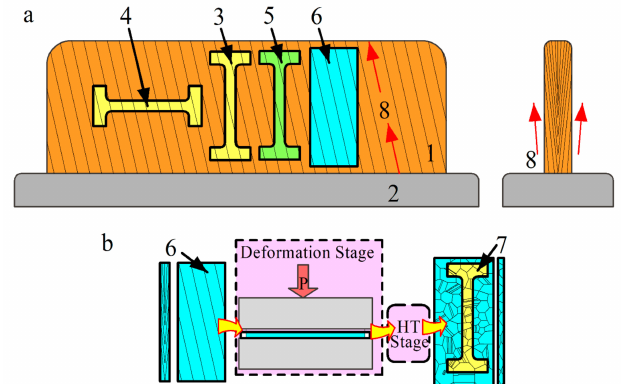
Figure 2. The tensile sample cut-o ff scheme ( a ) and thermomechanical treatment diagram ( b ). 1—thin-walled printed Cu-Al sample, 2—AISI 321 steel substrate, 3 and 4—as-grown samples for tensile test, 5—as-annealed sample, 6—sample for microstructural characterization and thermomechanical treatment, 7—deformed and then annealed sample, 8—columnar grain growth directions, P—pressure direction at deformation stage for 6th sample, HT—heat treatment stage after